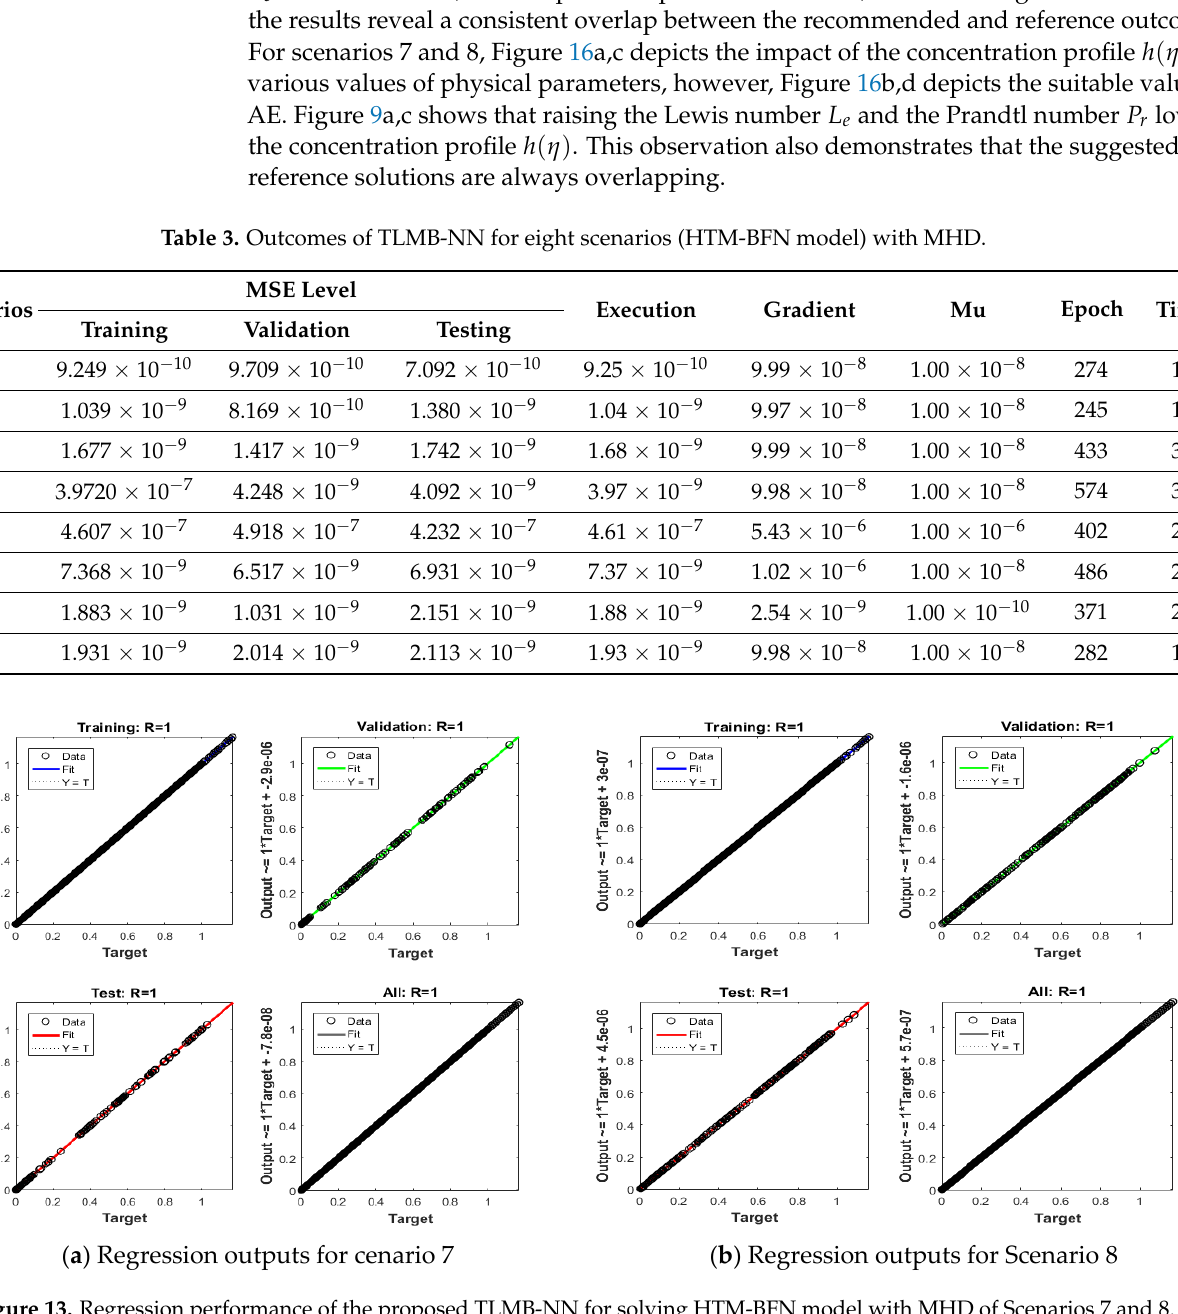
Figure 13 : Regression performance of the proposed TLMB-NN for solving HTM-BFN model with MHD of Scenarios 7 and 8.